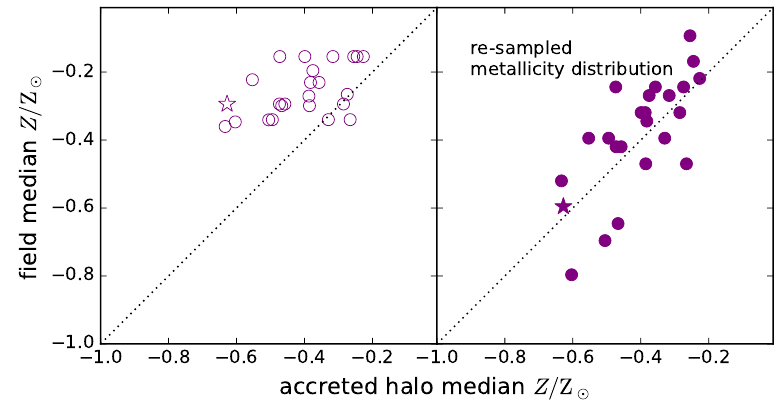
Figure 3. Result of applying the stellar population re-weighting illustrated in Figure 2 to the 24 MW- and M 31-like galaxies in the APOSTLE suite (AP-L2-V7-1-0, the example from Figure 2, is marked with a star). In each case, the field objects in the stellar mass interval between 0.2 and 0.5 dex more massive than the stellar mass of the accreted halo are selected. Before the re-weighting ( left panel ), the field objects typically have a median metallicity greater than that of the corresponding accreted halo (the dotted line indicates 1:1 agreement). After re-weighting ( right panel ), the medians of the metallicity distributions of the field objects and accreted halos agree, albeit with substantial